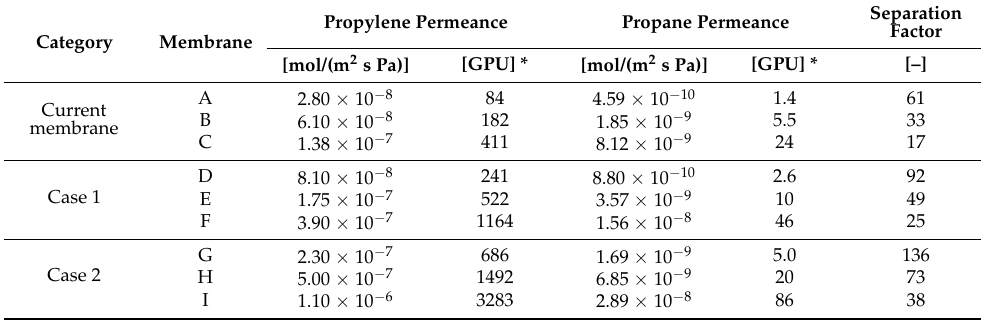
Table 1. Categories, permeance, and separation factor of the membranes used in this study. Category